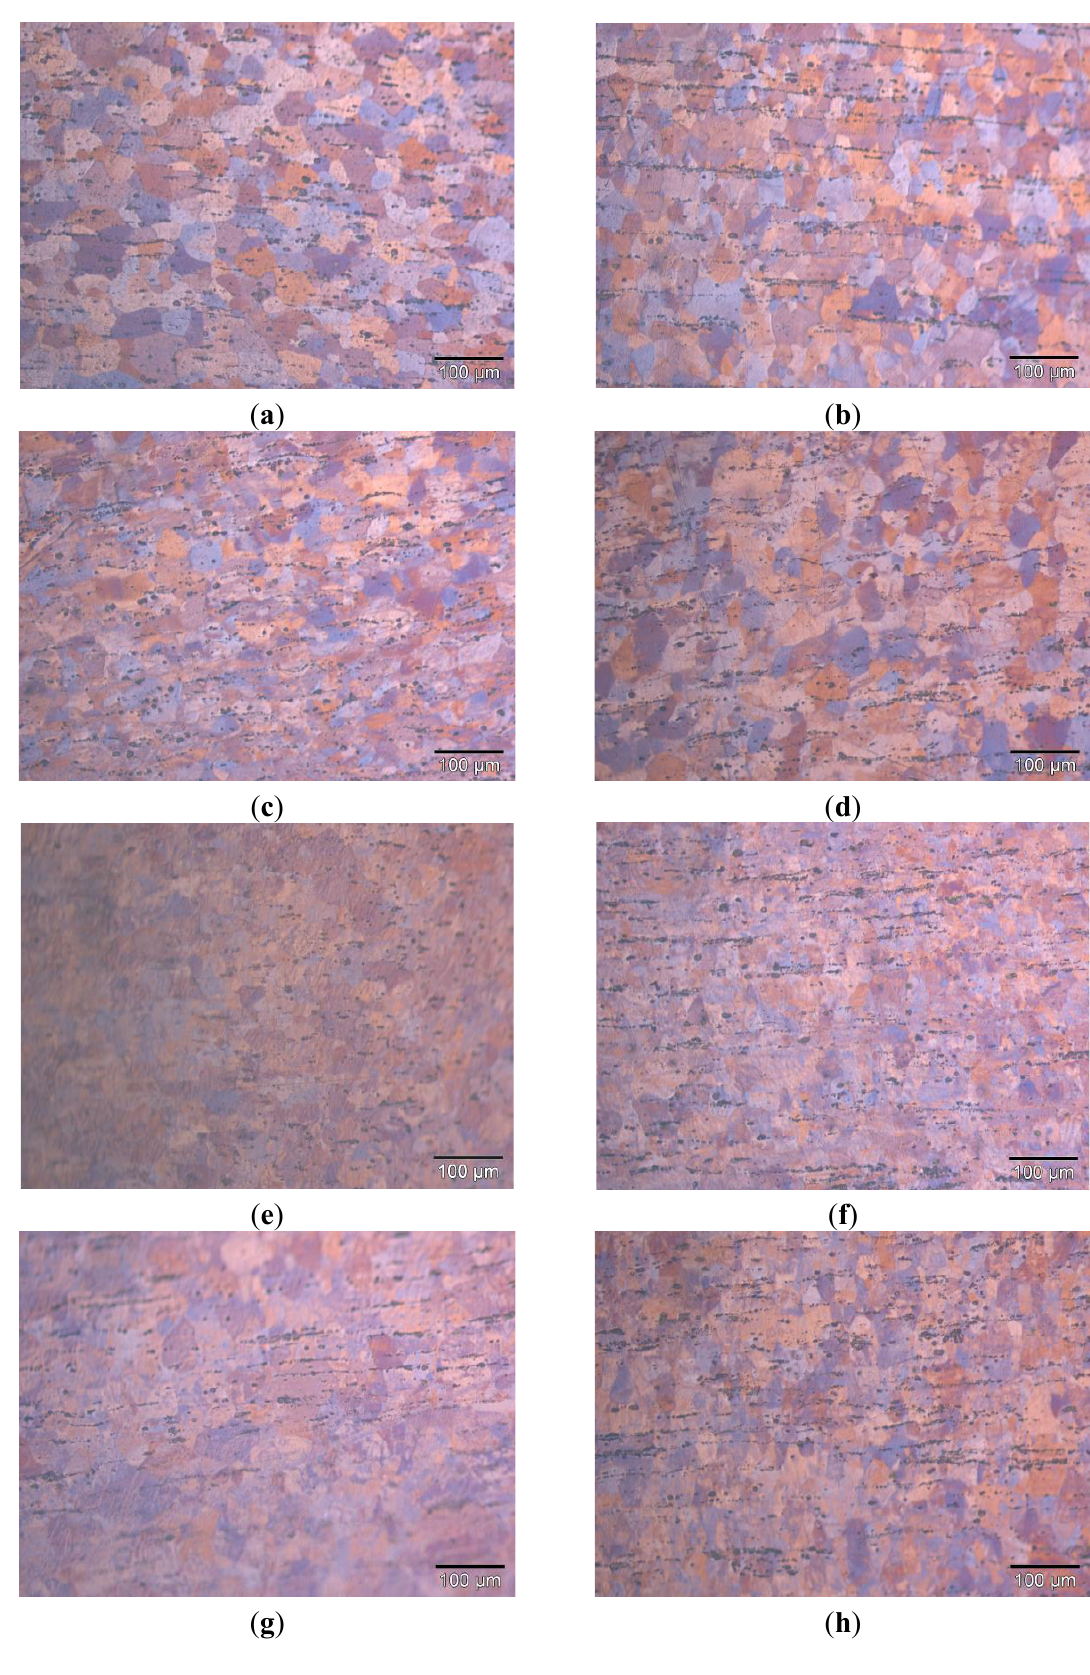
Figure 12. Optical micrographs of the connecting rods forged at the optimum temperature: ( a ) N0 − Z1; ( b ) N0 − Z2; ( c ) N0 − Z3; ( d ) N0 − Z4; ( e ) N2 − Z1; ( f ) N2 − Z2; ( g ) N2 − Z3; ( h ) N2 −